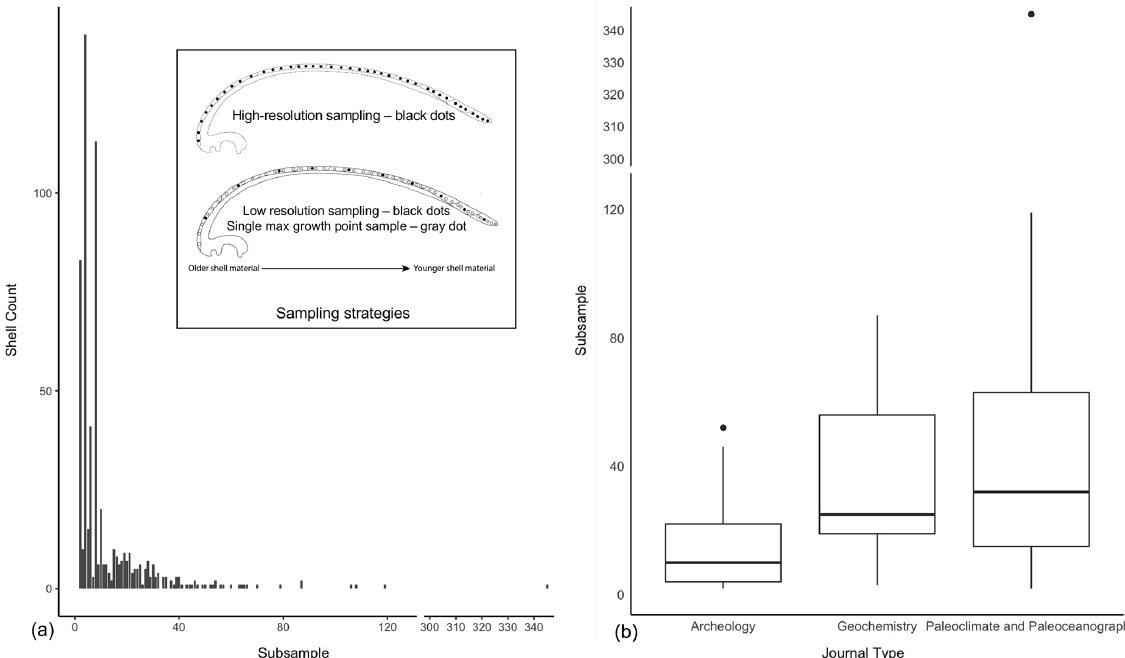
Figure 5. Distribution of occurrence of number of subsamples from an individual shell (a) . Panel (a) inset is a schematic of sampling strategies showing multiple degrees of sampling resolution. Box and whisker plot of subsamples per shell by journal type (b) , difference between each group is significant (ANOVA, Tukey, p < 0 .